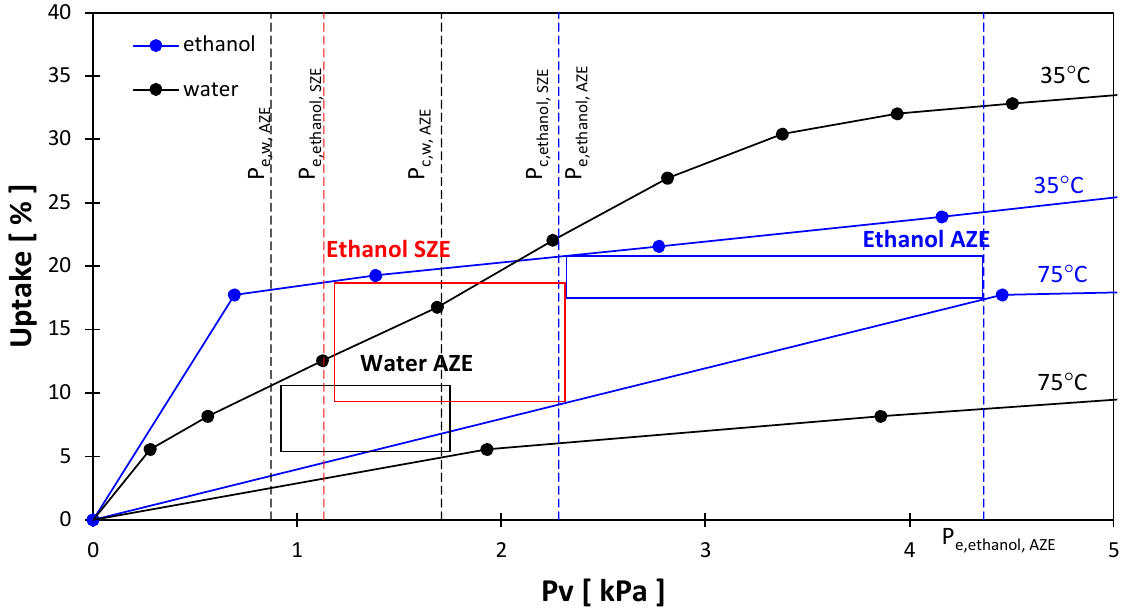
Figure 5. Equilibrium net cyclic adsorbate uptake: water AZE—black, ethanol AZE—blue, and ethanol SZE—red.